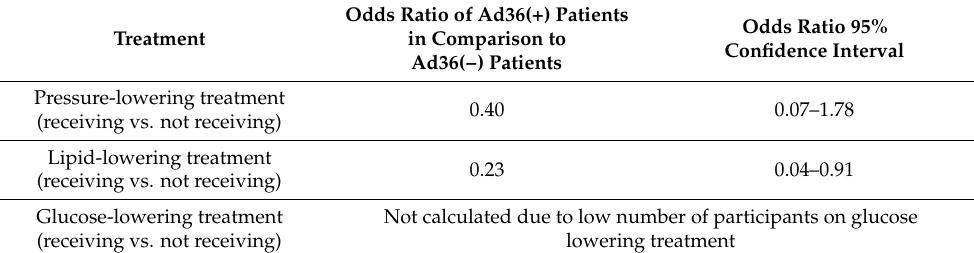
Table 4. Adv36-serostatus and odds of being on particular treatment adjusted through multiple logistic regression by: age, gender, sexuality (men who have sex with men vs. other), ARV (receiving TAF vs. not receiving TAF; receiving an INSTI vs. not receiving an INSTI), CD4 + cell percentage, and waist-to-hip ratio. Odds Ratio of Ad36(+) Patients Odds Ratio 95% Treatment in Comparison to Confidence Interval Ad36(−) Patients Pressure-lowering treatment 0.40 (receiving vs. not receiving)